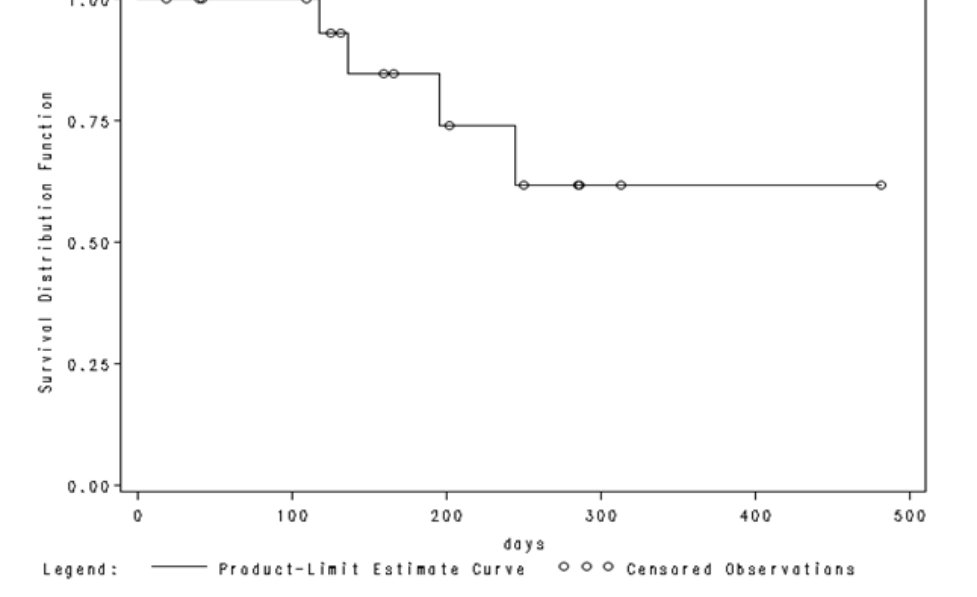
Fig. 2. Progression-free survival of patients with ovarian cancer.